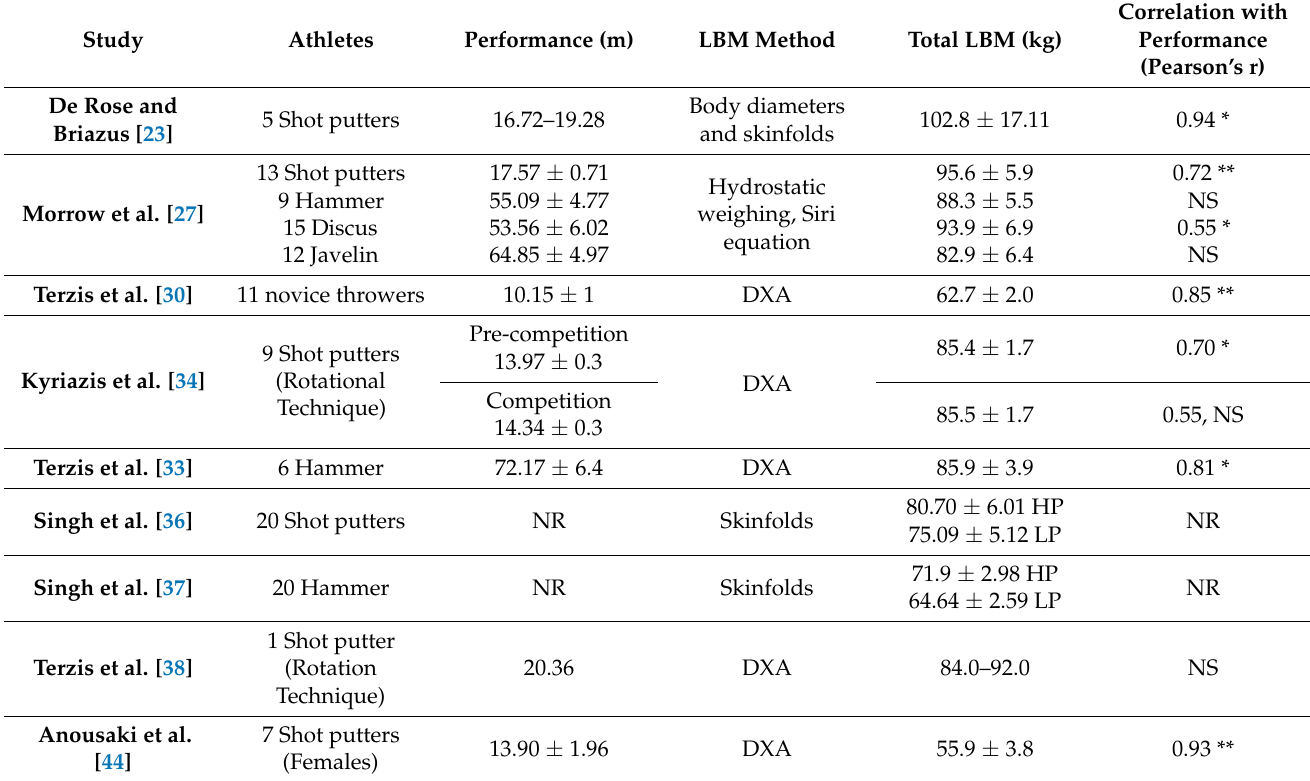
Table 1. Correlations between lean body mass and track and field throwing performance in male and female thrower